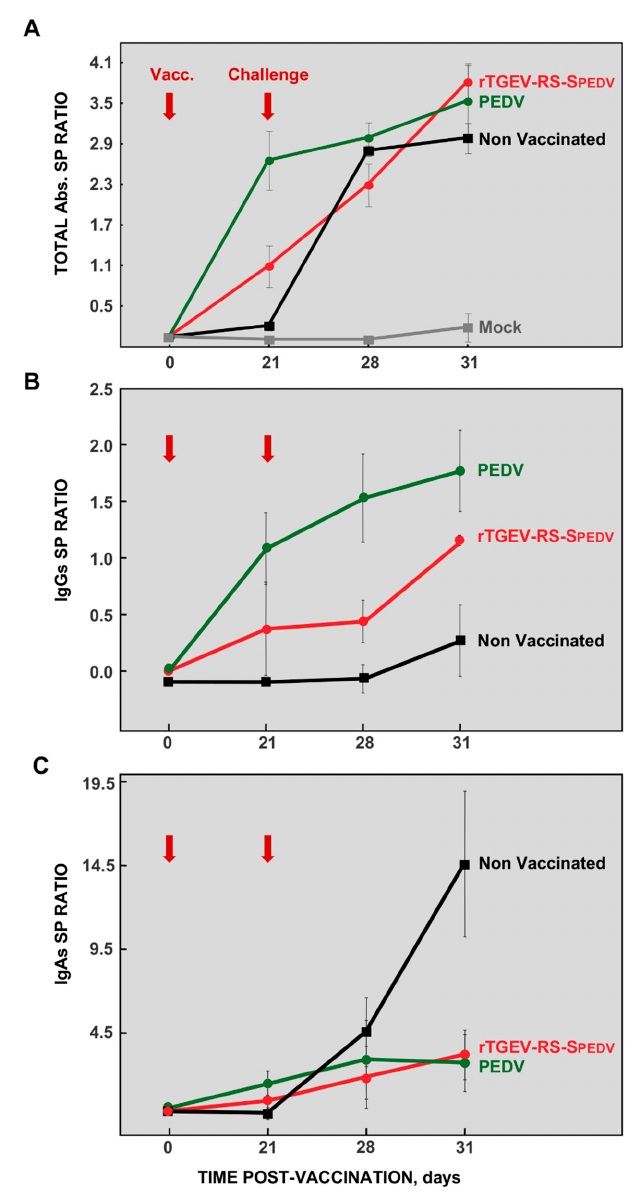
Figure 8. Humoral response induced in vaccinated animals. Serum samples from vaccinated and non-vaccinated animals were collected at the indicated times post-vaccination. Vaccination day (Vacc.) and challenge day were indicated by red arrows. Antibodies specific for PEDV were analyzed by ELISA, measuring total antibodies ( A ), IgGs ( B ) and IgAs ( C ). Mock, non-vaccinated and non-challenged animals (grey); non-vaccinated and challenged animals (black); animals vaccinated with the virulent PEDV-NVSL strain (green) or with the vaccine candidate rTGEV-RS-SPEDV (red). The values represent the mean from, at least, three different animals. Error bars represent the standard deviation for each value.